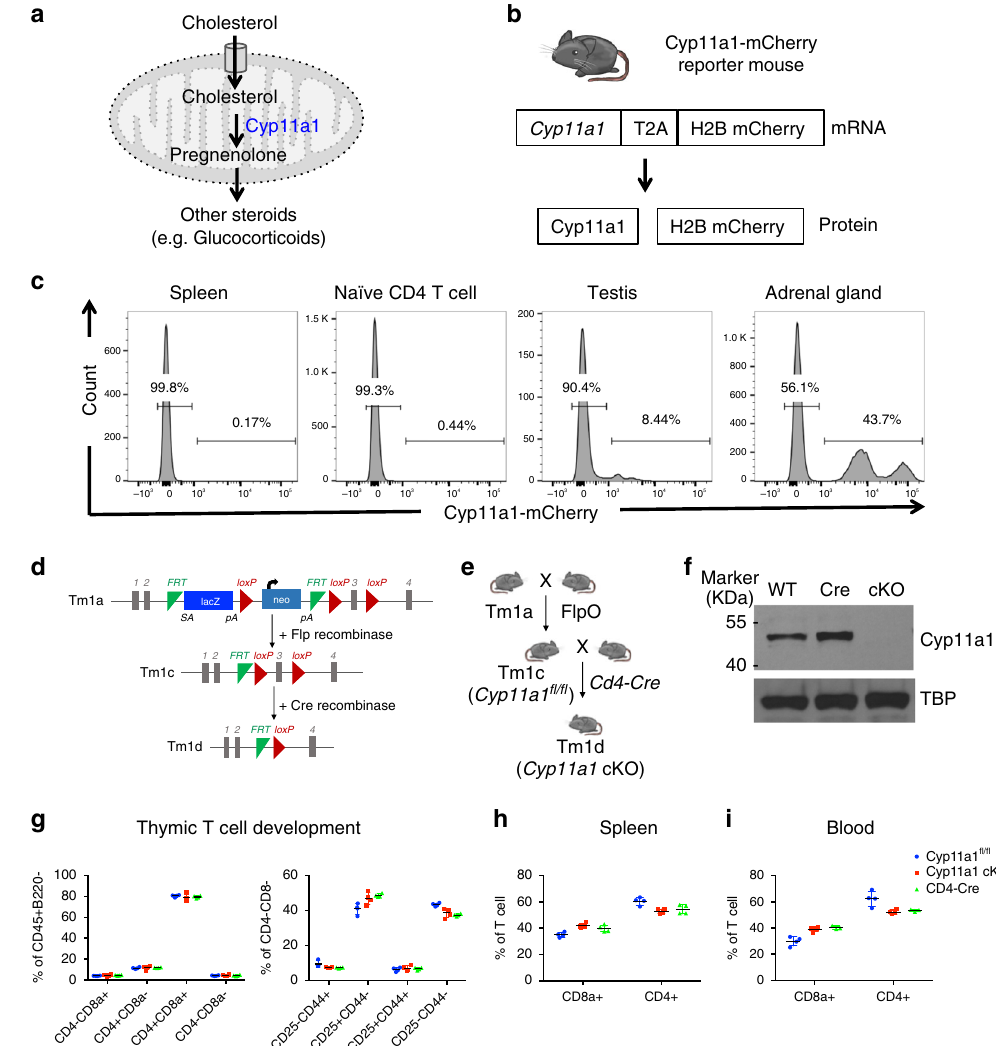
Fig. 1 Generation of a de novo steroidogenesis reporter and conditional knockout mice. a . Schematic of de novo steroidogenesis pathway. Cyp11a1 is the fi rst and a key rate-limiting enzyme of the pathway. b . Cyp11a1 -reporter mice synthesize a fusion protein that self-cleaves due to presence of a T2A peptide and dissociates into Cyp11a1 and H2B-mCherry. c Cyp11a1-mCherry reporter mice report Cyp11a1 expression accurately. Single-cell suspensions of tissues and naïve splenic CD4 + T cells were analyzed by fl ow cytometry. Gating: All cells>Singlets>Live cells>Cyp11a1-mCherry. Representative of three independent experiments; each experiment contains 3 – 4 mice. d , e Generation of a Cyp11a1 conditional knockout (cKO) mice. Schematic presentation of the The targeting allele ( d ) and T cell-speci fi c Cyp11a1 cKO ( Cd4 − Cre; Cyp11a1 fl / fl ) generation ( e ). f Cyp11a1 knockout ef fi ciency of Cre recombinase in T cells. Splenic naïve T helper cells from cKO ( Cd4 -Cre; Cyp11a1 fl / fl ) mice or control mice (wild type and Cd4 -Cre) were activated under Th2 differentiation condition, and analyzed for Cyp11a1 protein expression by western blot. TATA-binding protein (TBP) used as loading control. g Normal thymic development of T cells in Cyp11a1 cKO. Thymus was harvested from Cyp11a1 cKO and control ( Cd4 -Cre and Cyp11a1 fl / fl ) mice, dissociated into single-cell suspension, stained with fl uorescent conjugated anti-CD4, CD8, B220, CD45, CD25, and CD44 antibodies, and analyzed by fl ow cytometry. Gating: all cells>Singlets>Live cells>CD45 + B220 − >CD4, CD8 (left panel). CD4 + CD8 + cells represent double positive (DP) stage, CD4 + CD8 − and CD4 − CD8 + cells represent single positive (SP) stage, CD4 − CD8 − cells represent double negative (DN) stage. DN cells of the left panel were gated to show CD25 and with s.d., N = 4 biologically independent animals. ( h , i ). Flow cytometric analysis shows normal distribution of Cyp11a1 cKO T cells (CD4 + and CD8 + ) in the peripheral blood and spleen. Error bars represent mean with s.d., N = 4 biologically independent